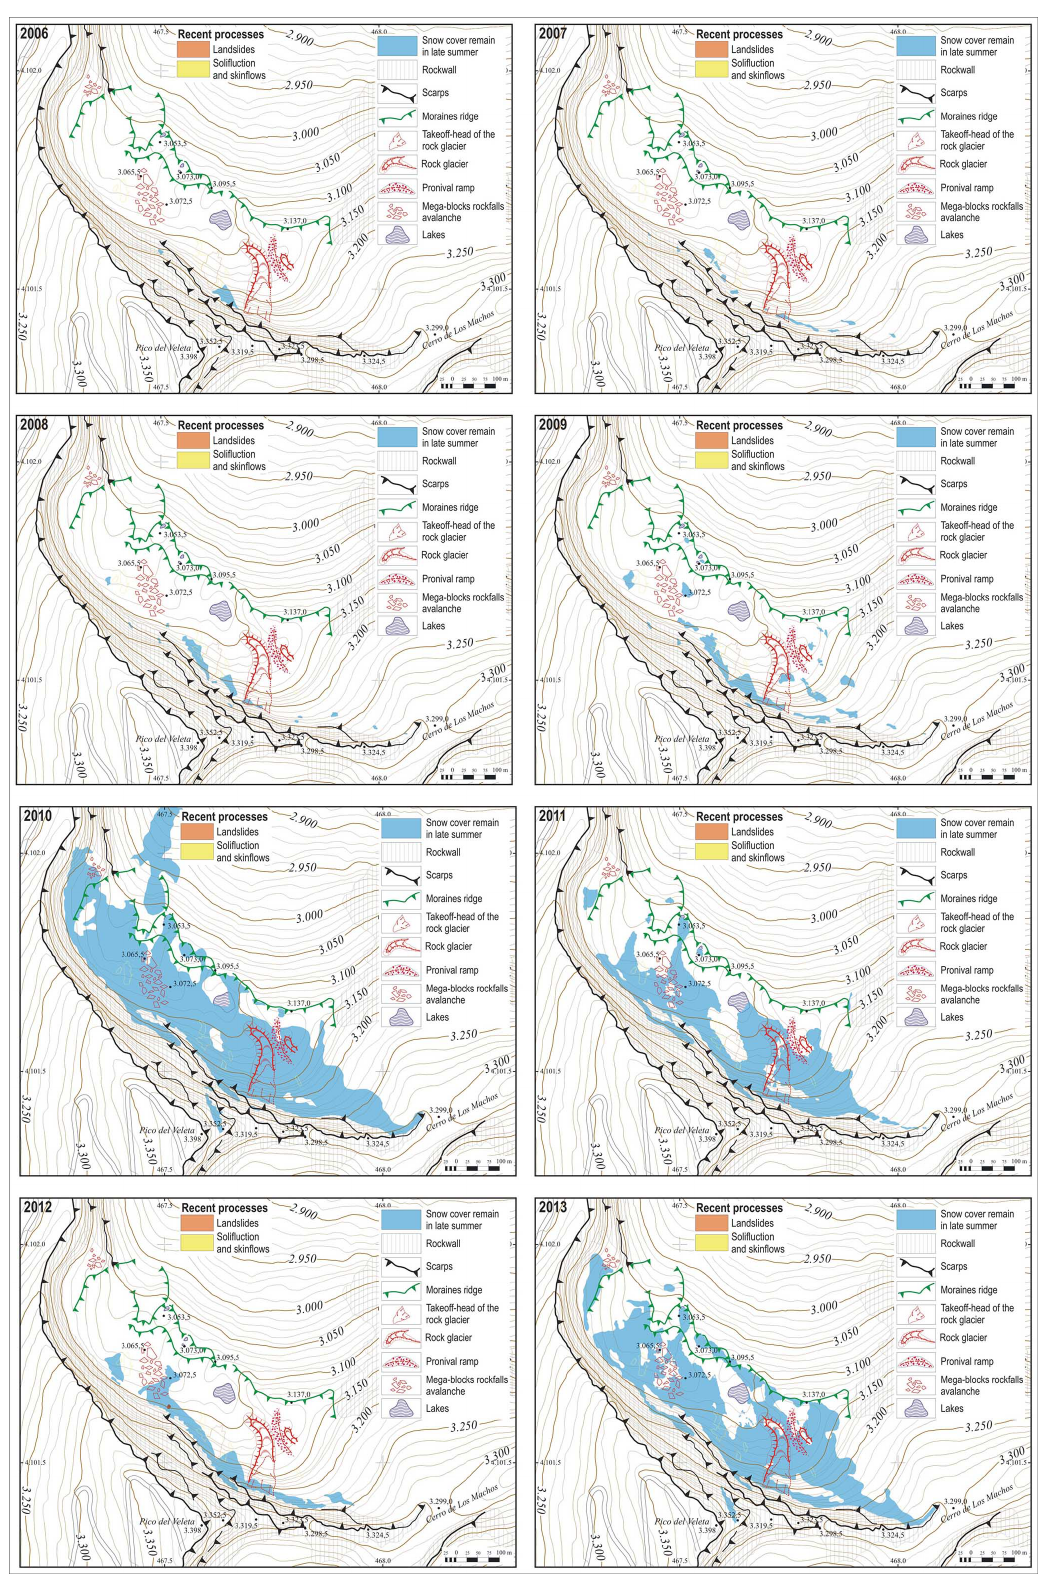
Figure 4. Ground snow cover on the Corral del Veleta at the end of August during the 2007–2011 period.